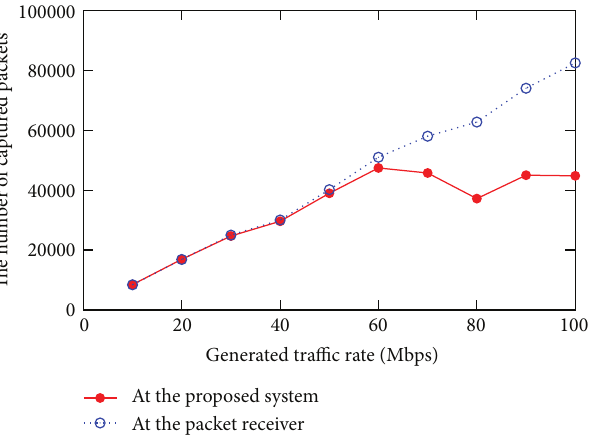
Figure 13: Evaluation on packet capture